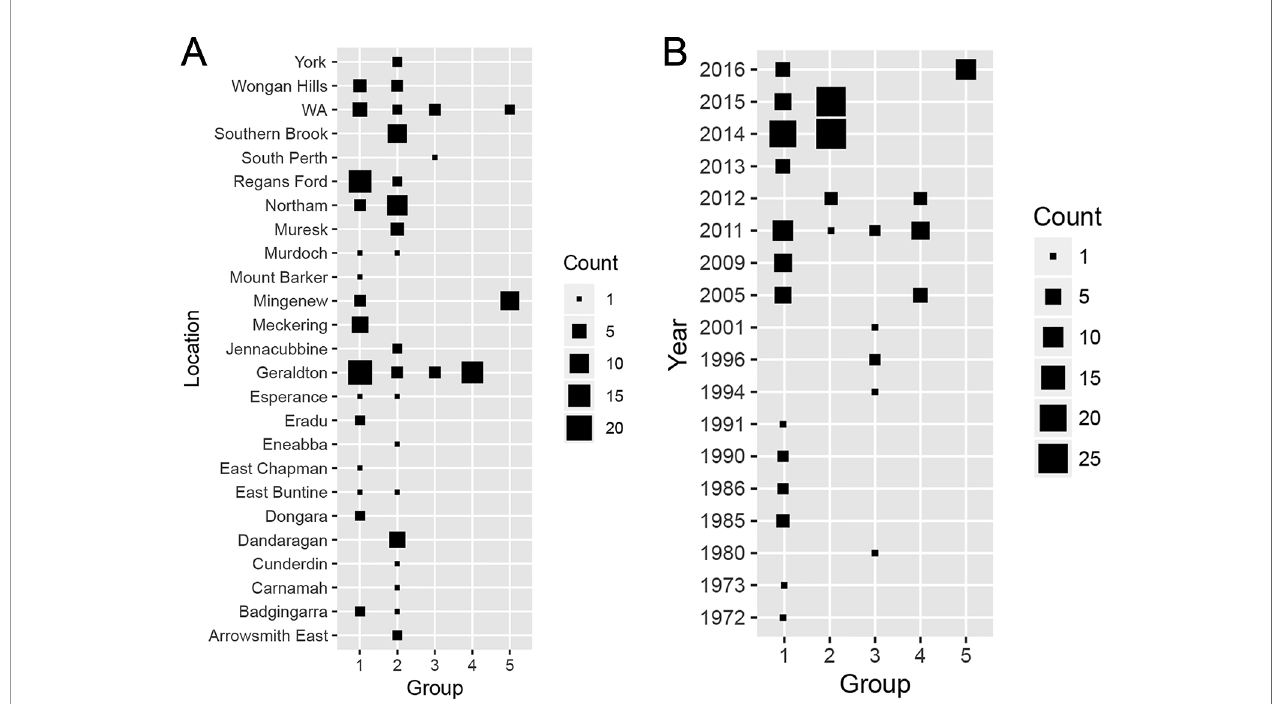
FIGURE 5 | Distribution of discriminant analysis of principal components (DAPC)-grouped Australian P. nodorum isolates over sampling (A) locations and (B) times.